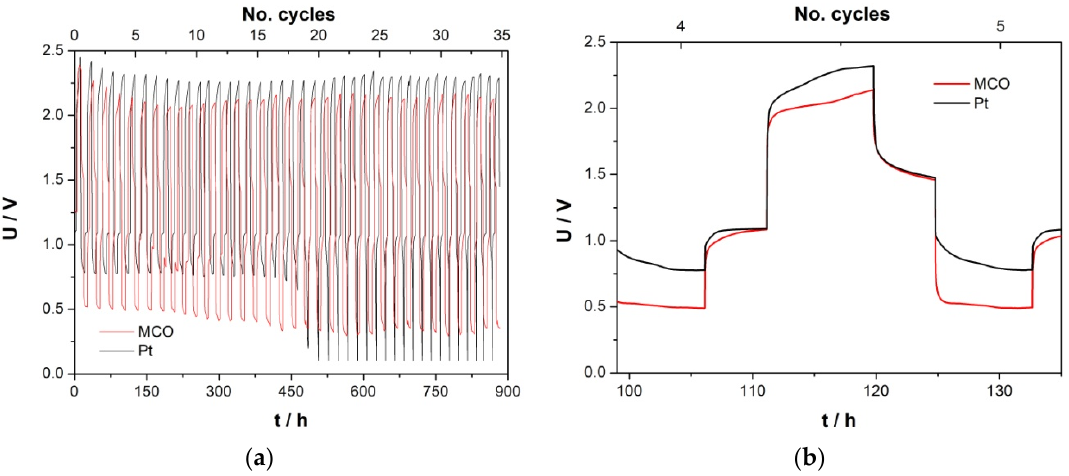
Figure 13. ( a ) Average values of zinc/air cell performance in 30 wt.% H 2 O/ChAcO + 0.01 M ZnAcO 2 electrolyte during cycling at 100 µA cm − 2 (2.82 mA g − 1zinc ) in ambient air for 26 h per cycle (8 h charge/discharge each) in El-Cell. ( b ) Representation of the fifth cycle. Voltage cut-off limits were fixed to 2.5 and 0.1 V. The absolute charge and discharge capacity value was limited to 2.2 and 2.0 mAh, respectively.